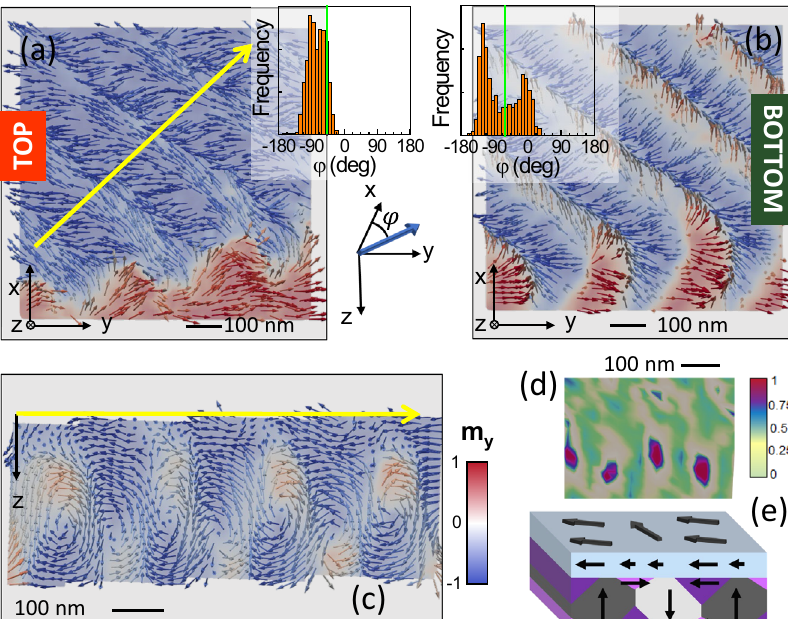
Fig. 4 Vectorial tomographic reconstruction of m(Gd) at MD1 ( m y contrast). a View of the ð x ; y ; 14nm Þ plane (Top Gd-Co layer); ( b ) View of the ð x ; y ; 255nm Þ plane (bottom Gd-Co layer); Insets are histograms of in-plane angular orientations respect to the x -axis ( φ ) within top/bottom layers respectively. Red/blue regions correspond to average in-plane domains with opposite m y contrast. Vertical line marks stripe domain orientation ( φ MD 1 stripe ¼ (cid:2) 50 (cid:3) ). c Cross-section across yellow arrow in ( a ). Note the uniform m y contrast at top layer and the asymmetric size of opposite closure domains. d Detail of the vorticity map at cross section in ( c ). Note the zig-zag con fi guration of high vorticity regions corresponding to cores of closure domain vortices. e Sketch of domain con fi guration across the two maxima in the angular distribution as β (cid:4) 35 (cid:3) . Note that the ¼ the stripe pattern orientation (marked by a vertical line at φ MD 1 stripe (cid:2) 50 (cid:3) at the inset of Fig. 4(a)). Near the bottom of the ( β ¼ 120 (cid:3) and Δ φ ¼ 150 (cid:3) ) corresponding to opposite in-plane